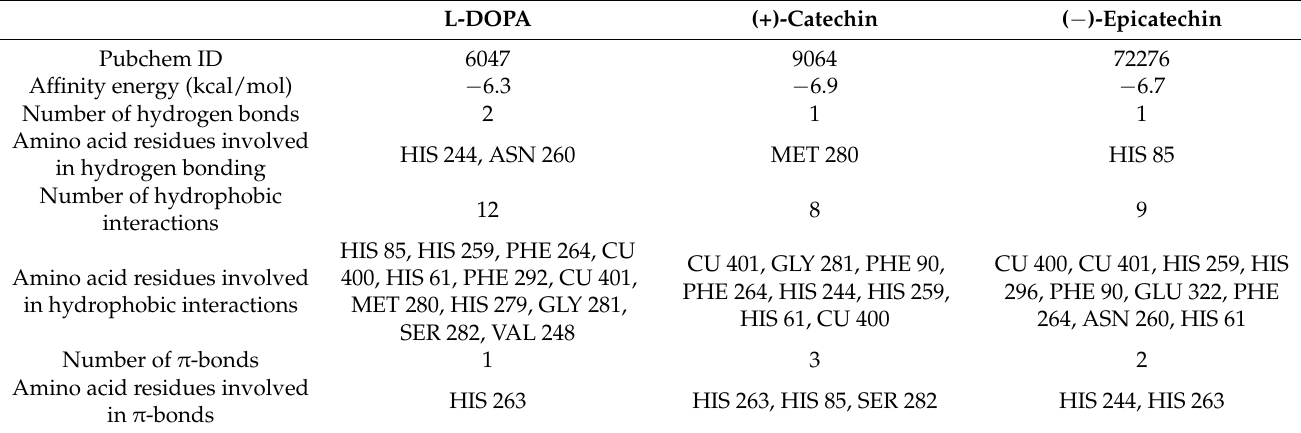
Table 3. Binding affinity and binding sites of L-DOPA, (+)-catechin and ( − )-epicatechin to tyrosinase. L-DOPA (+)-Catechin ( −